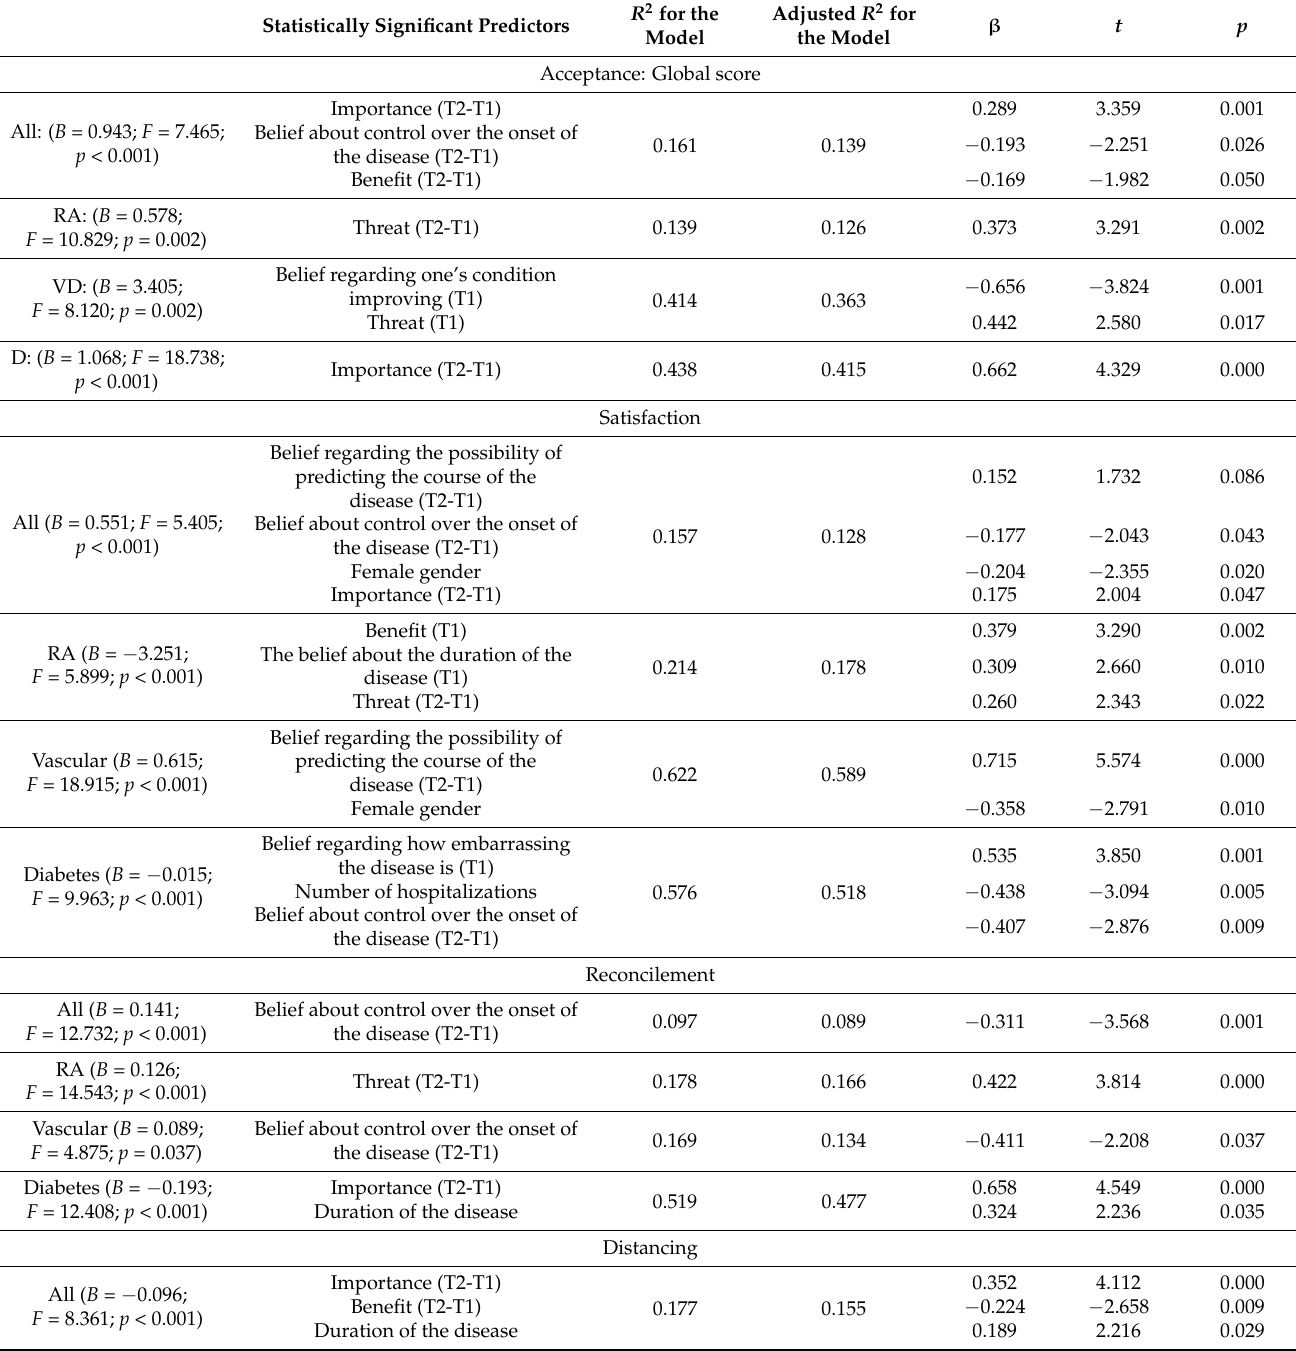
Table 5. Predictors of changes in Acceptance of Living with the